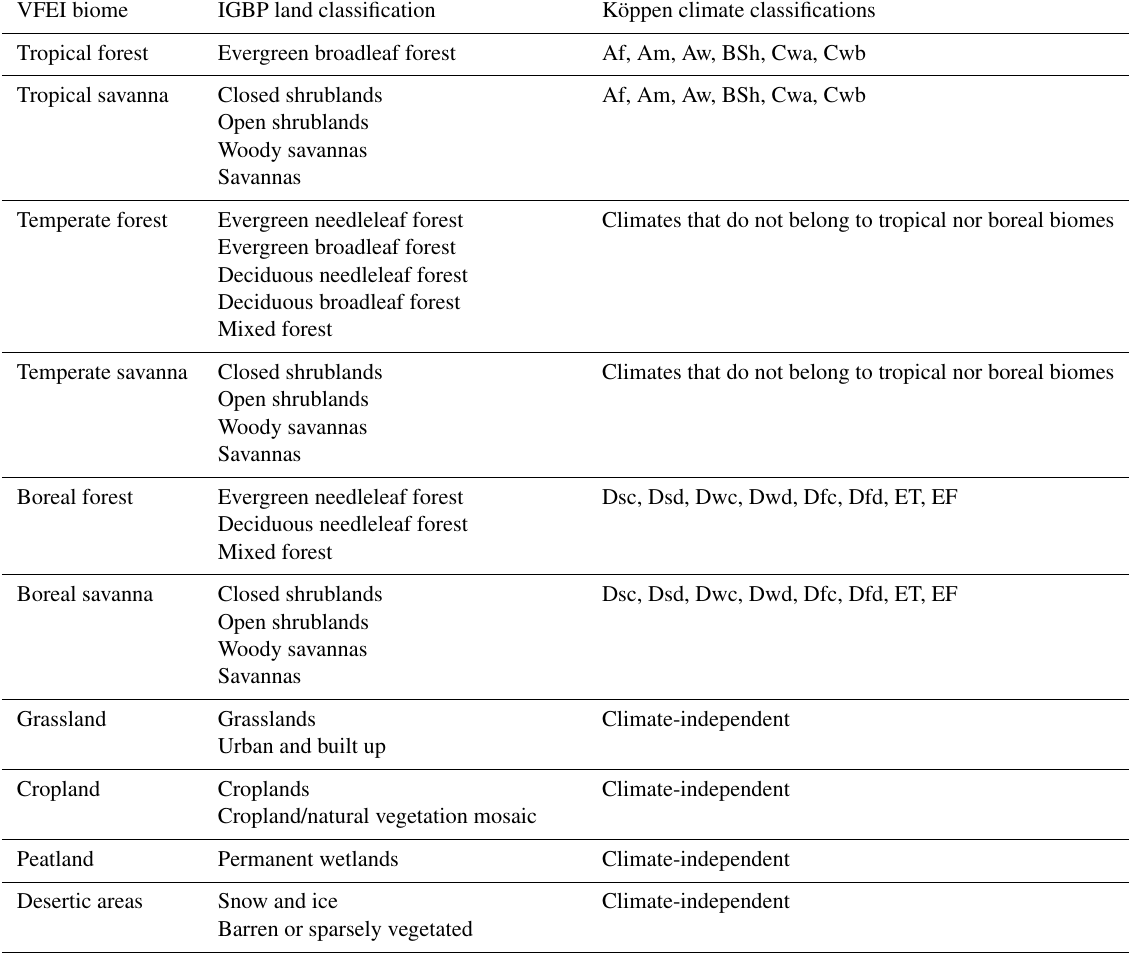
Table 2. Biomes considered in VFEI with their corresponding mapping using IGBP land classes and Köppen climate classifications. See footnote for the key of each